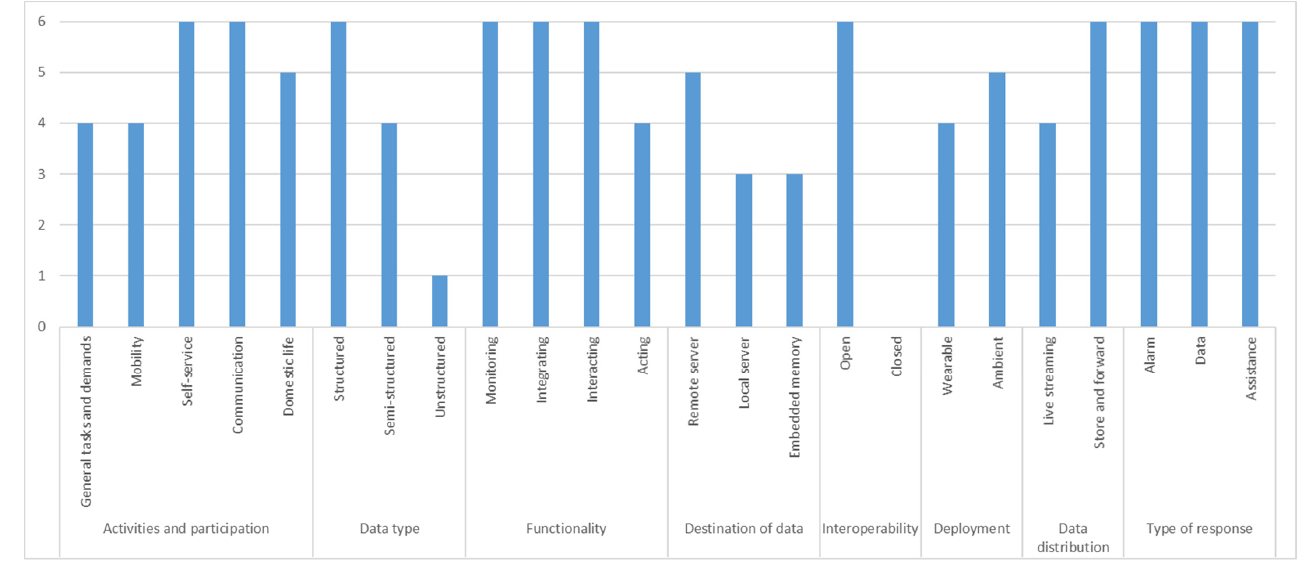
Figure 7. Data quality-oriented AAL taxonomy-based classification summary.